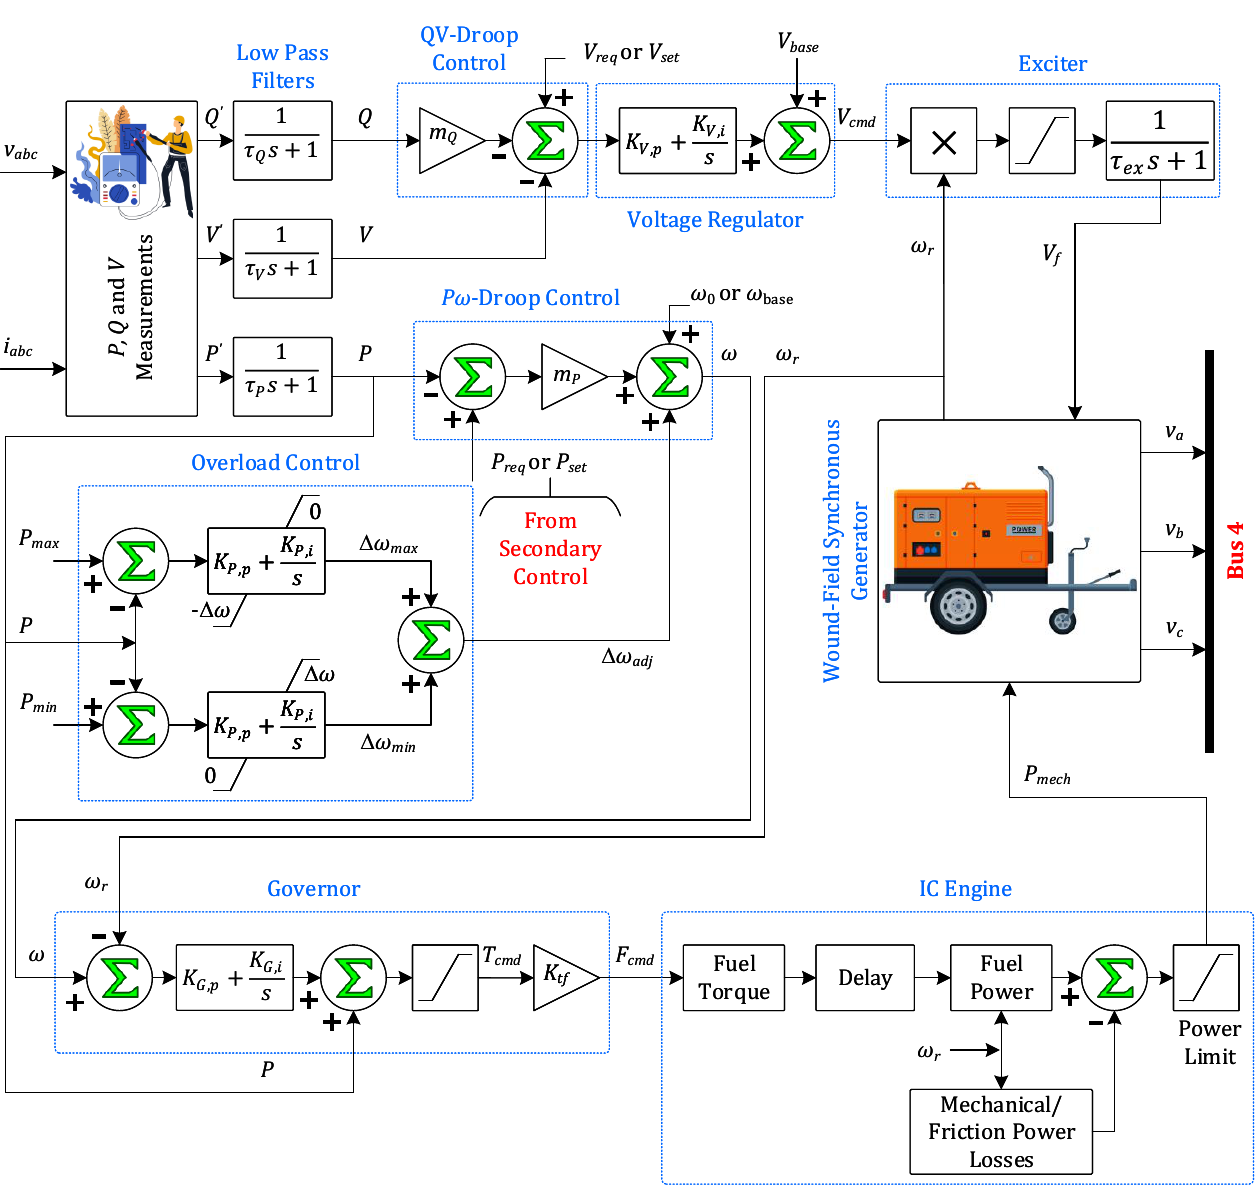
Figure 4. Primary control strategy for ICE-based DGU (i.e., diesel